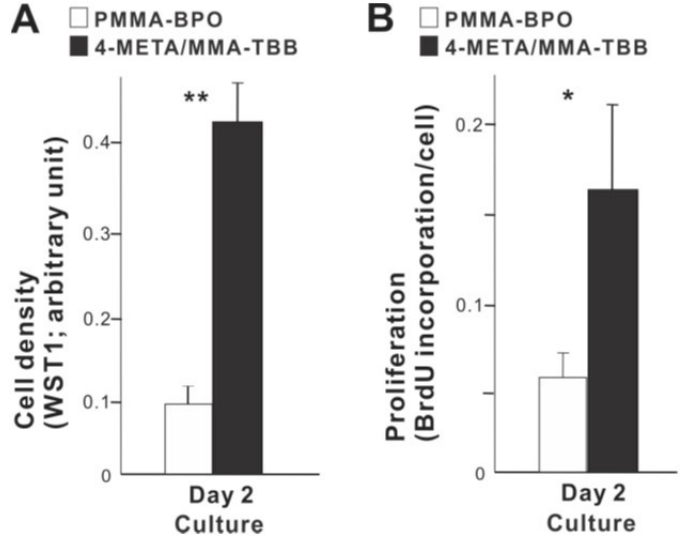
Figure 5. Proliferative activity of osteoblasts on two different materials. ( A ) Cell density evaluated on day 2 using the WST-1 assay. ( B ) The rate of proliferation evaluated on day 2 using the BrdU incorporation assay. * p < 0.05, ** p < 0.01, statistically significant difference between the two materials.